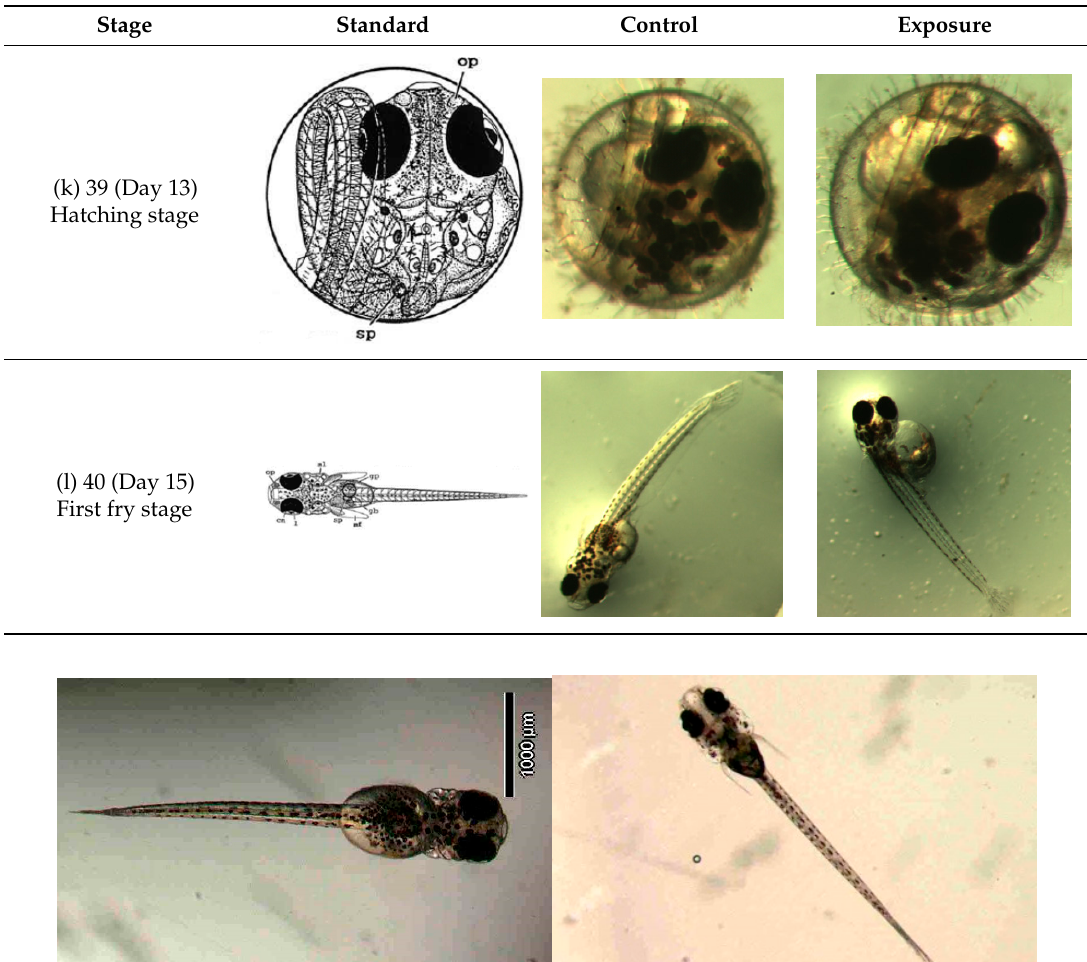
Figure 11. Illustration of medaka larvae 3 days post-hatching ( left ); and 13 days post-hatching ( right ).